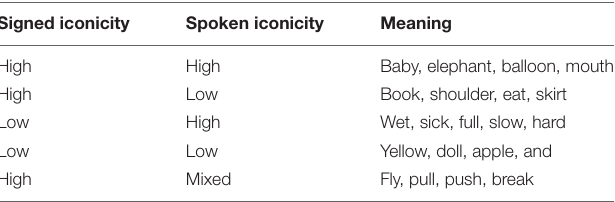
TABLE 3 | Examples of meanings with high and low iconicity in signed and spoken languages.